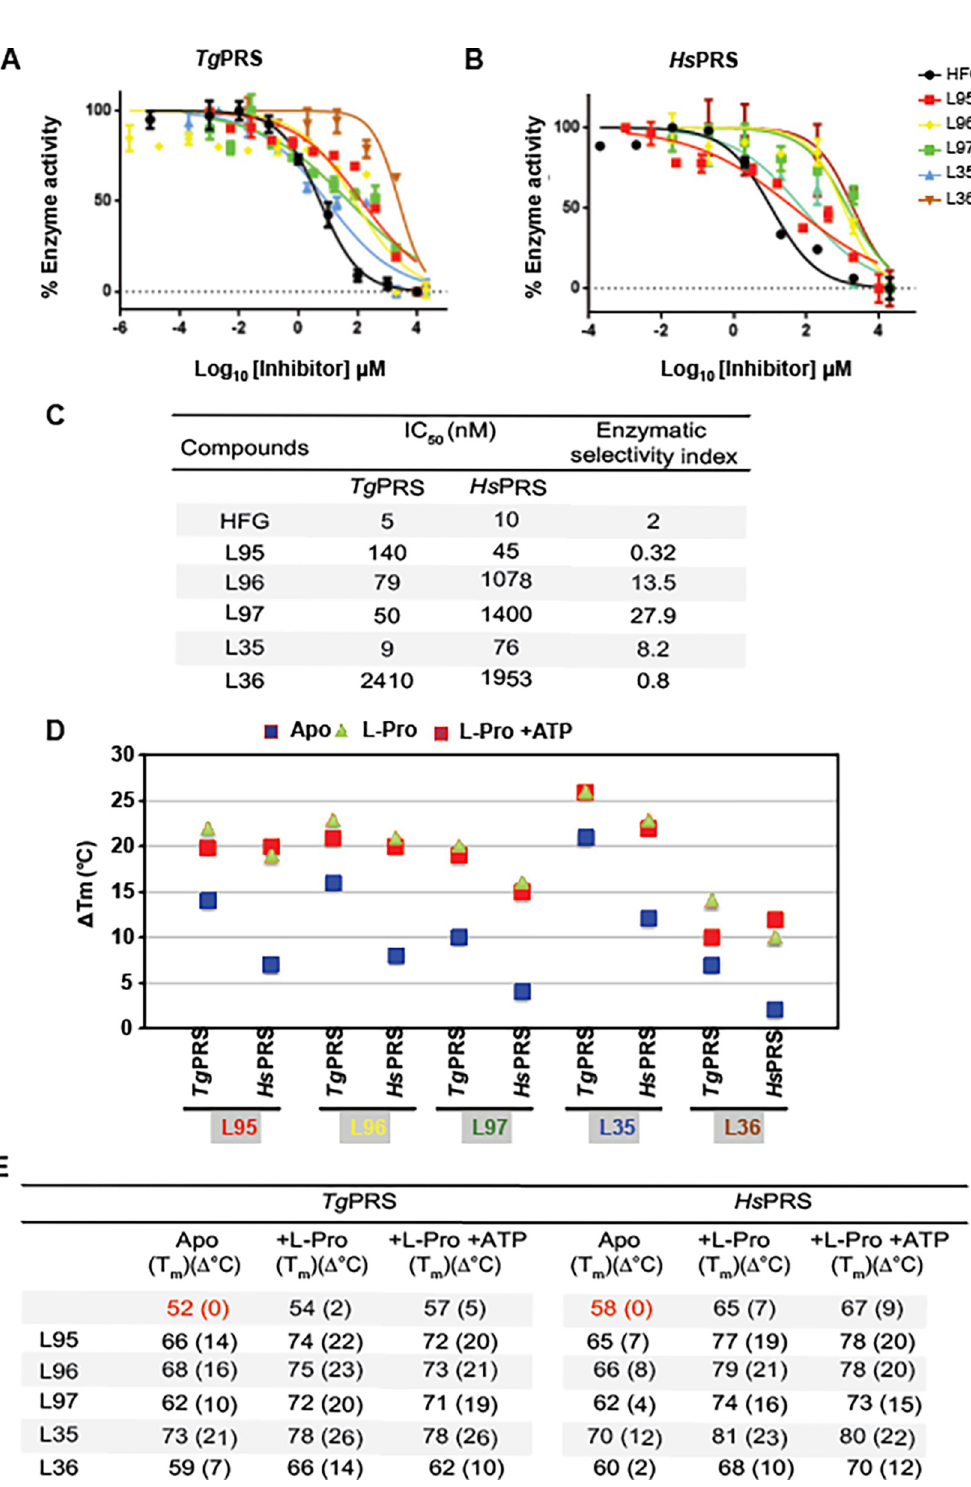
Fig 5. In vitro assessment and binding affinity. Aminoacylation activity inhibition assays were performed for (A) Tg PRS, and (B) Hs PRS with HFG and the five compounds. The dose-dependent sigmoidal curves were used to calculate IC 50 values for each compound for the respective PRSs. Error bars represent mean ± SD. Data are shown as mean ± SD (n = 3 independent experiments). (C) The IC 50 values (nM) are shown. (D/E) Thermal shift assays were performed to evaluate the melting temperature-based binding affinity for each of the five compounds with Tg PRS and Hs PRS. The five